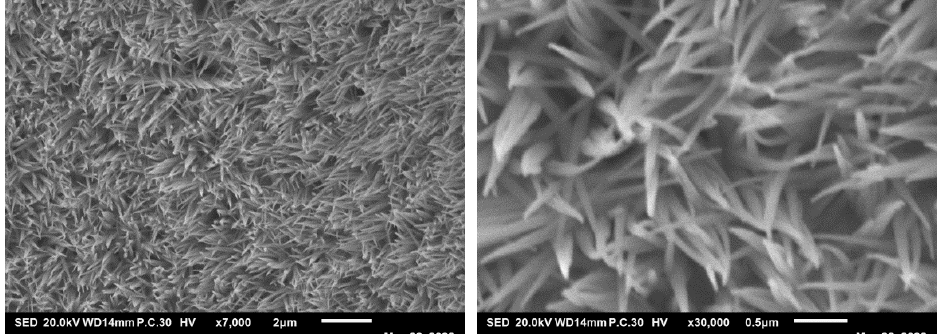
Figure 10. Chronoamperometry test of Ni 4 Co 4 Fe 2 -LDH/NF at 10 mA·cm − 2 .